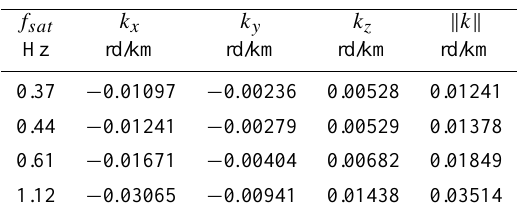
Table 3. The computed characteristics of the most intense identi- fied wave for the four studied frequencies using the k-filtering tech- nique. The wave vectors are in the quasi-perpendicular direction, ∼− 87 ◦ θ ( k,B 0 )